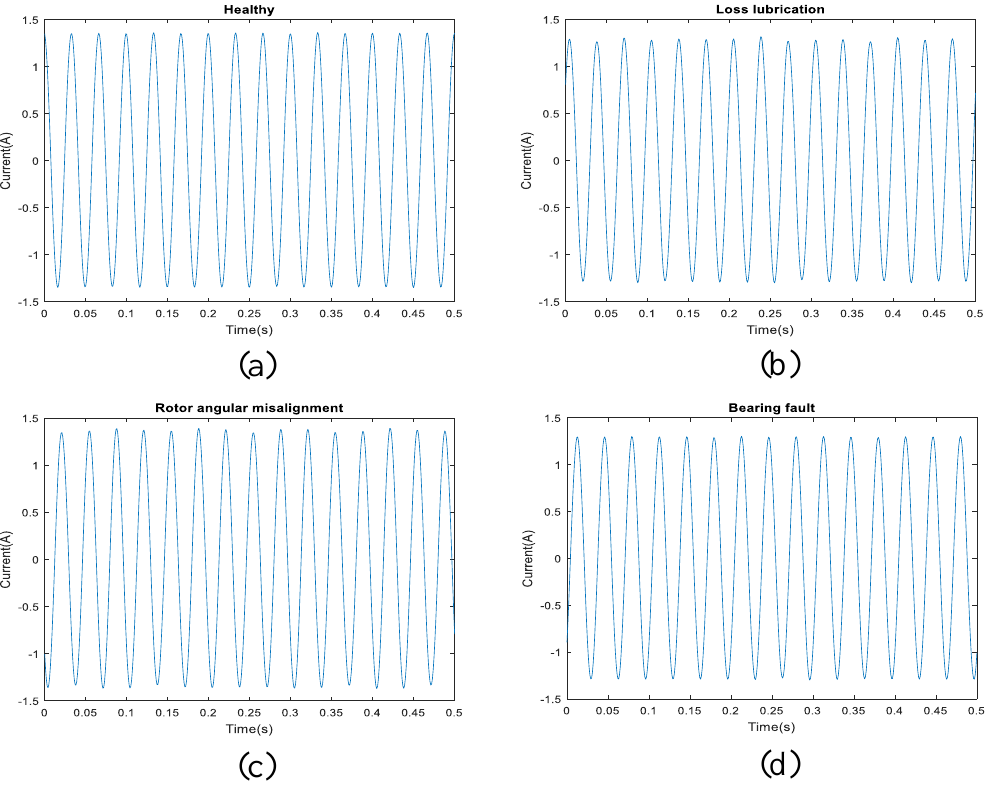
Figure 7. Generator output current: ( a ) Healthy; ( b ) Loss of lubrication; ( c ) Rotor angular misalignment; ( d ) Bearing fault.